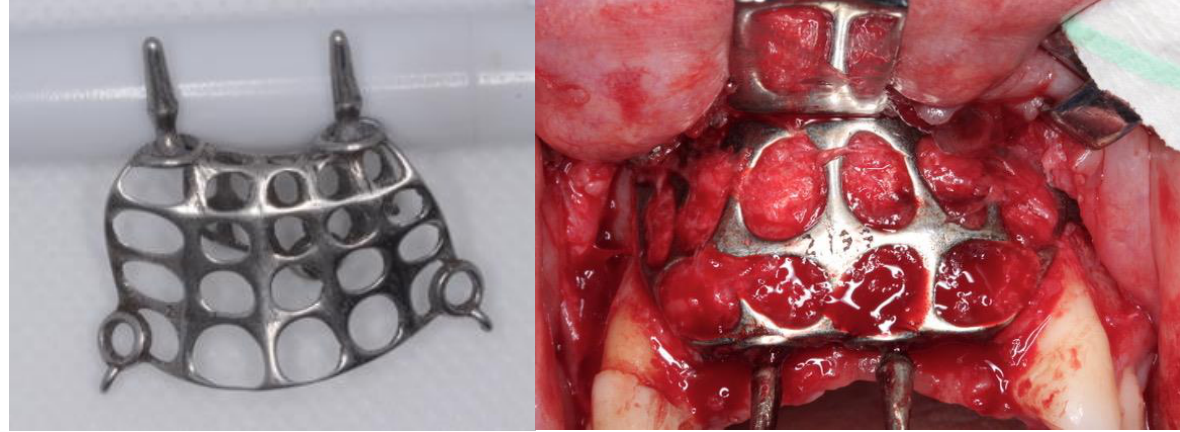
Figure 1. Grade 5 titanium mesh used in this study.